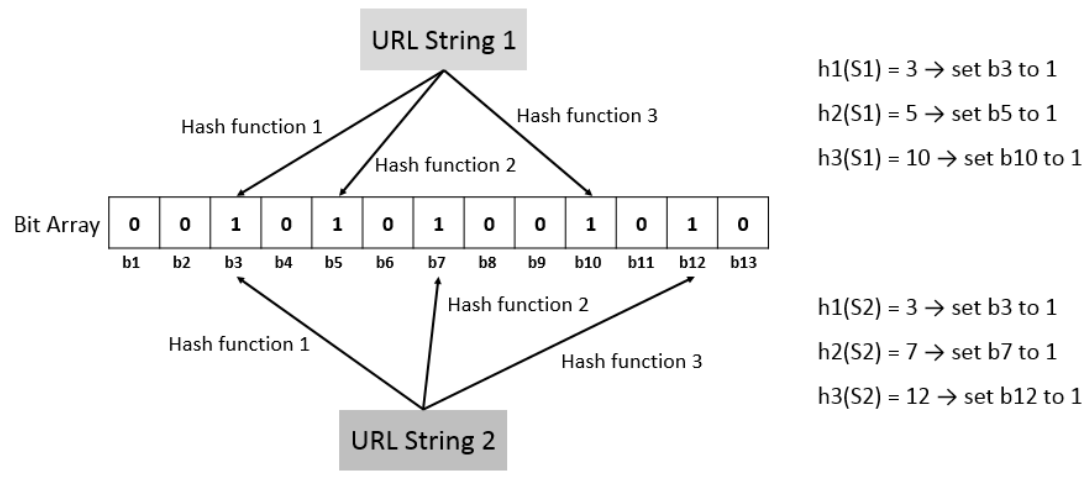
Figure 6. The concept of Bloom filter.